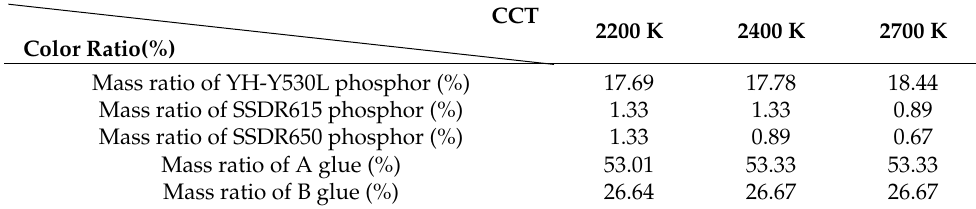
Table 1. Phosphor and glue